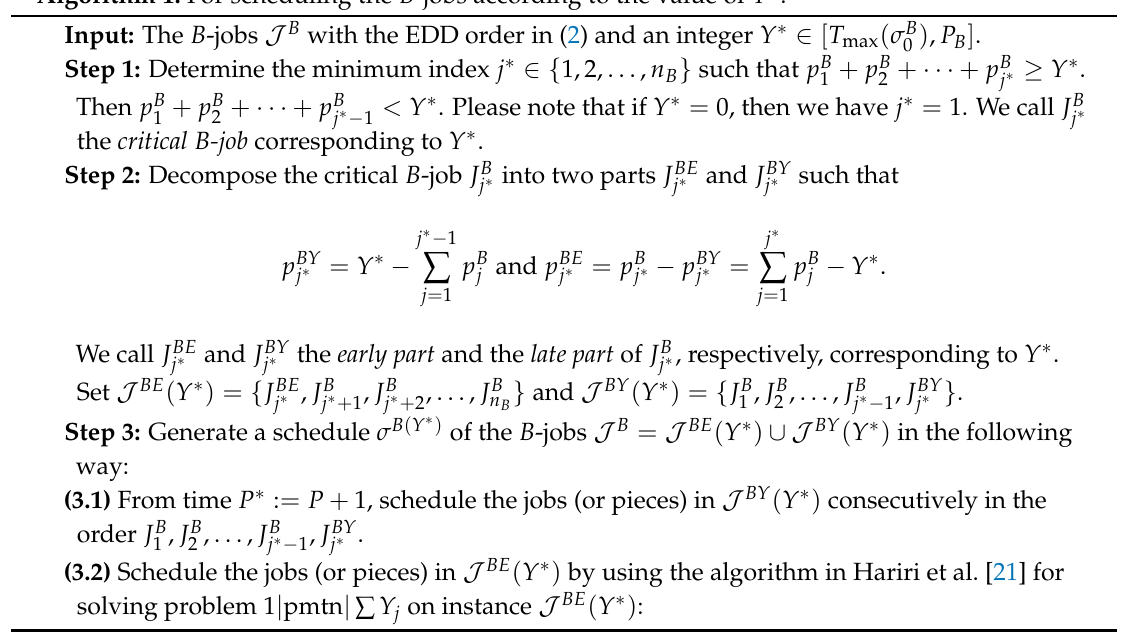
Algorithm 1: For scheduling the B -jobs according to the value of Y ∗